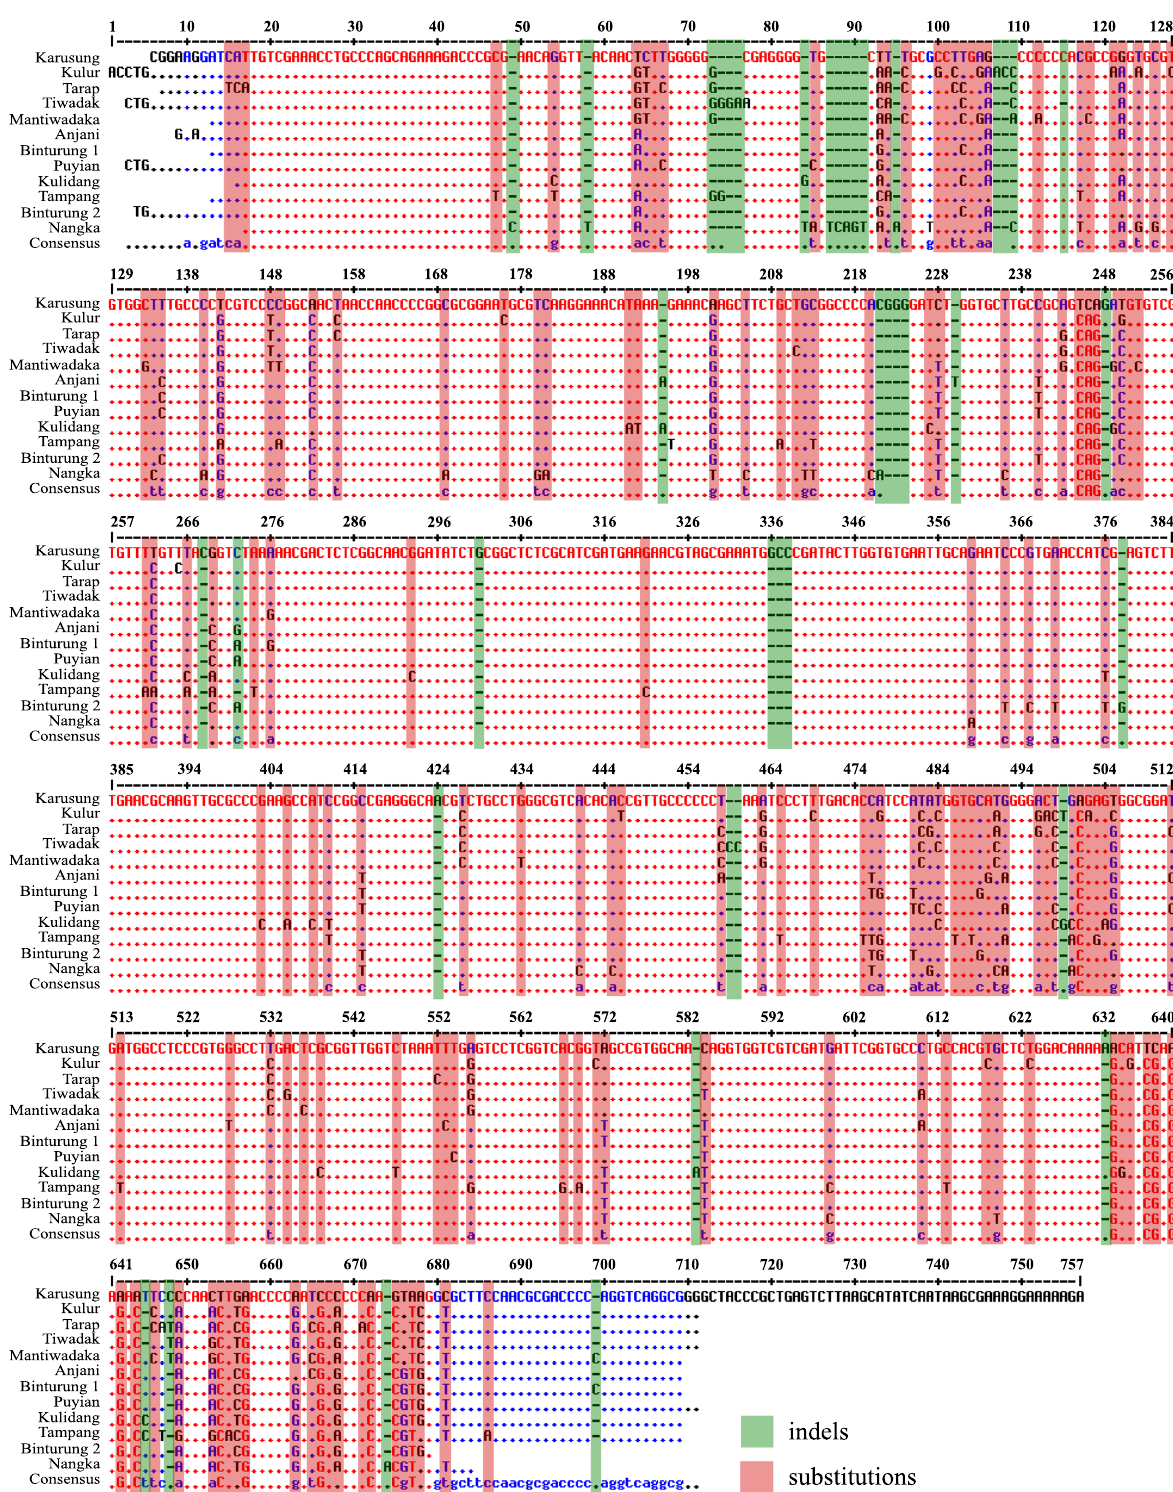
Fig. 3 Multiple sequence alignments, showing two mutational events, i.e., substitutions and indels, from ITS sequence of endemic breadfruit ( Artocarpus spp.) from South Borneo,